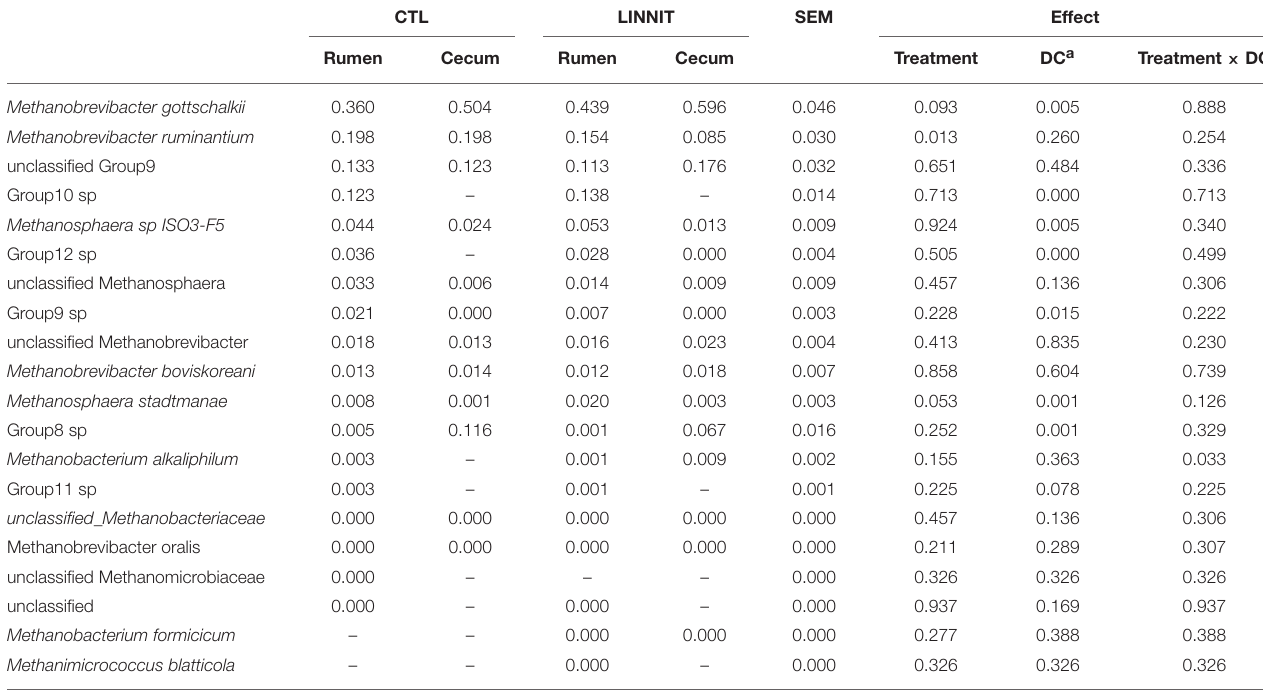
TABLE 4 | Methanogenic species relative abundance proportions, based on 16S rDNA reads taxonomic classification, in the rumen and cecum of bulls receiving a control (CTL) or linseed plus nitrate (LINNIT) supplemented diet. CTL